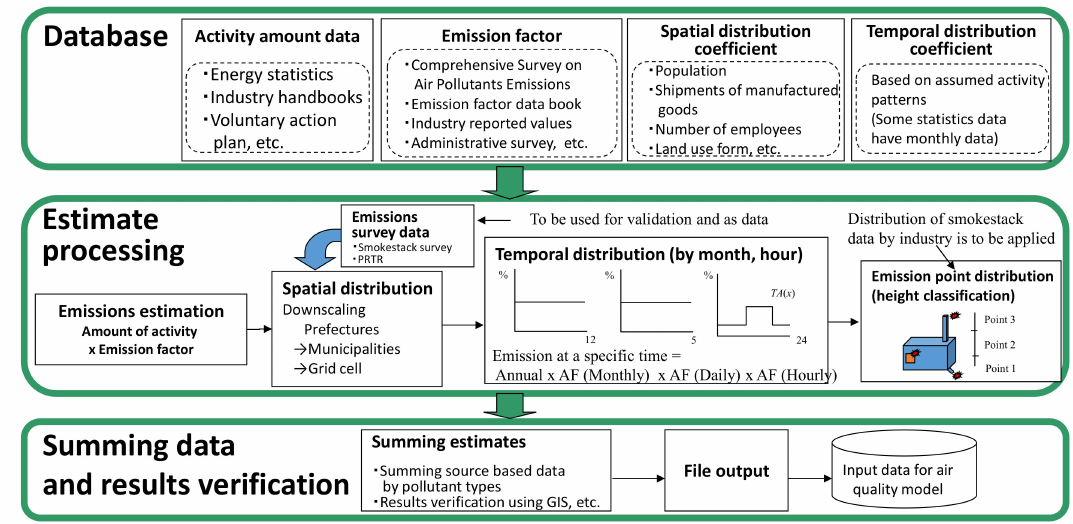
Figure 8. Outline of G-BEAMS.